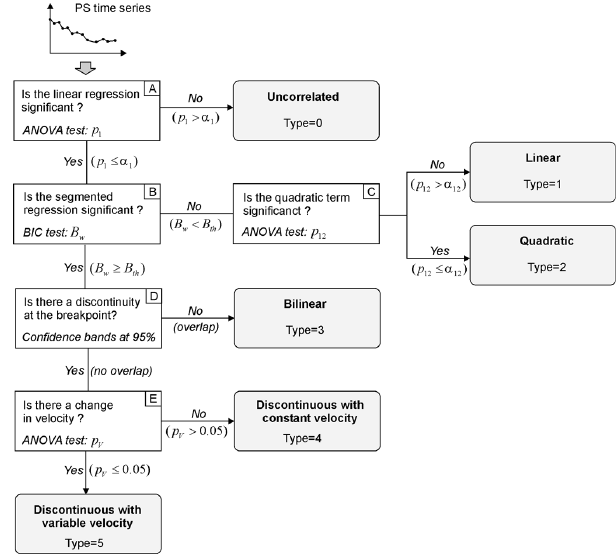
Fig. 2. Workflow of the proposed method for the automatic classifi- cation of PSI time